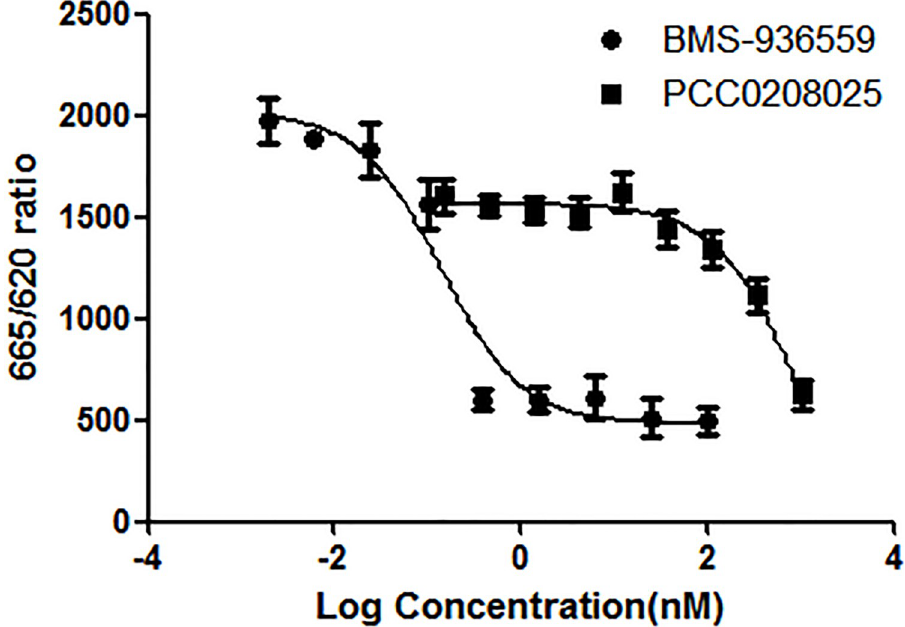
Fig 2. The inhibitory effects of PCC0208025 against PD-1 and PD-L1 binding. In HTRF assay, Tag2-PD-1 (20 nM final), PCC0208025 (0.15, 0.46, 1.37, 4.12, 12.35, 37.04, 111.11, 333.33 and 1000 nM, final) or BMS-936559 (0.002, 0.006, 0.024, 0.10, 0.39, 1.56, 6.25, 25 and 100 nM final), and Tag1-PD-L1 (2 nM final) were diluted in Binding Domain diluent buffer, and added one after the other to a 384-well plate for a total volume of 10 μ l. After 15 min pre- incubation, an addition of 10 μ l of detection reagent containing 1.83 nM anti-Tag1-EuK and 66.7 nM anti- Tag2-XL665 was added into the assay well. The signals (665 nm/620 nm ratio) were obtained on Tecan M200 PRO. HTRF ratio = (OD 665 nm /OD 620 nm ) × 10 4 . The results showed that BMS-936559 and PCC0208025 presented high activity with IC 50 of 0.54 nM and 235